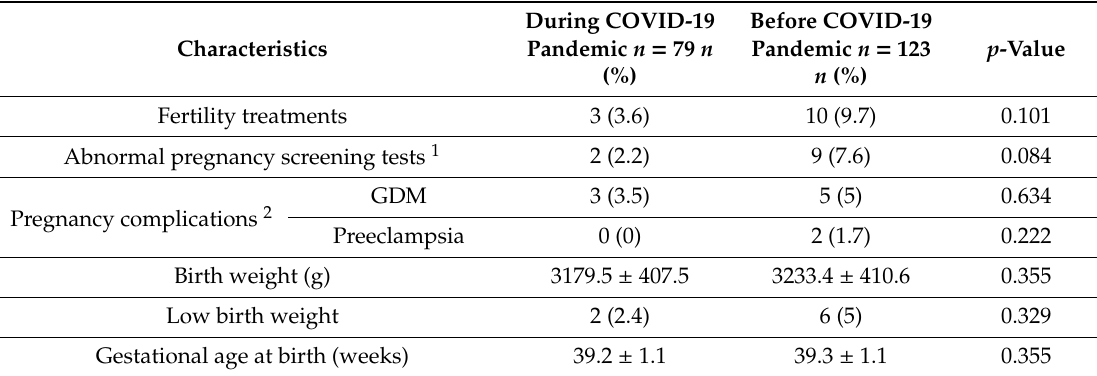
Table 2. Pregnancy and delivery data.